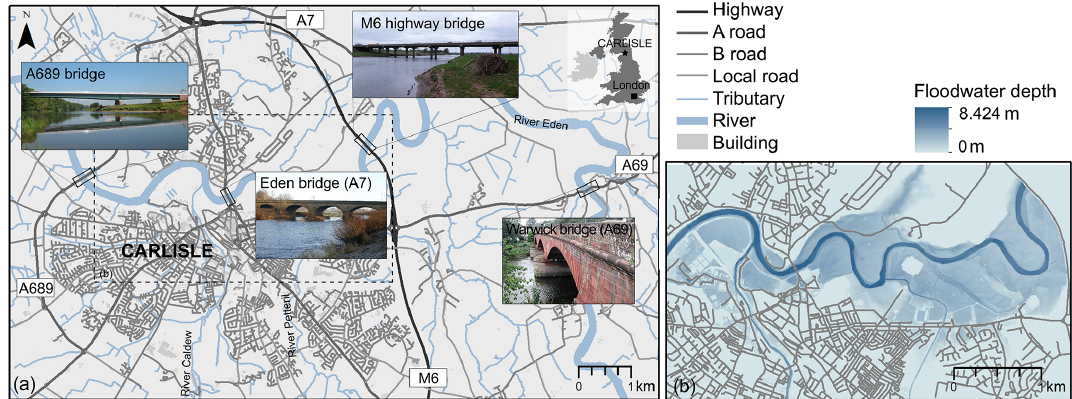
Figure 3. The case study is the city of Carlisle, UK: (a) general overview of Carlisle upon the River Eden, connected north–south by three road bridges (the A689, A7 and M6 bridges) and west–east by the Warwick Bridge (A69); (b) flood hazard map for Carlisle, as simulated with LISFLOOD-LP for a 1-in-500-year flood event (null floodwater depth implies dry areas).